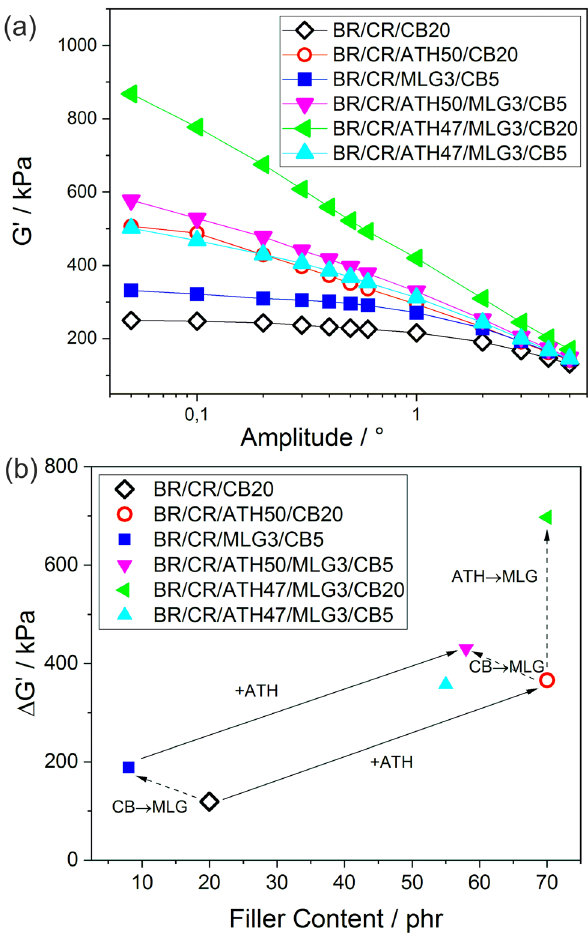
Figure 4: Rheology of uncured rubber composites: amplitude sweep; ( a ) storage modulus as a function of strain amplitude, ( b ) di ff erence between initial and fi nal storage modulus vs fi ller content. For ( b ) : solid line is addition of 50 phr ATH; dashed line is the substitution of 15 phr CB with 3 phr MLG, or 3 phr ATH with 3 phr MLG,